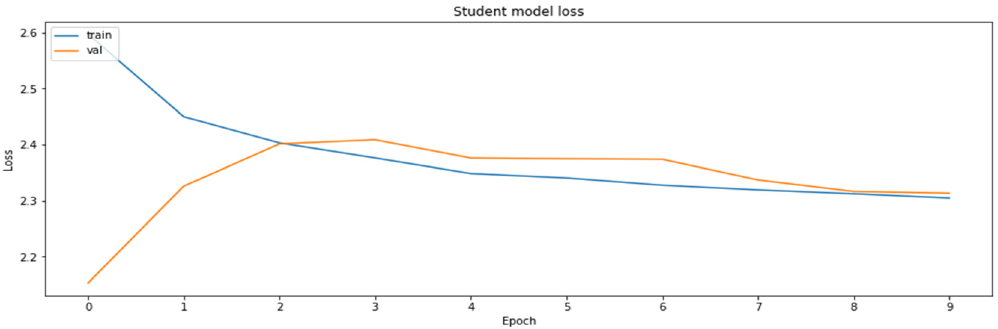
Figure 13. Training and the validation datasets obtained during the model distillation process.